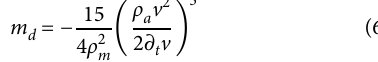
can be estimated from Eq. 5 d